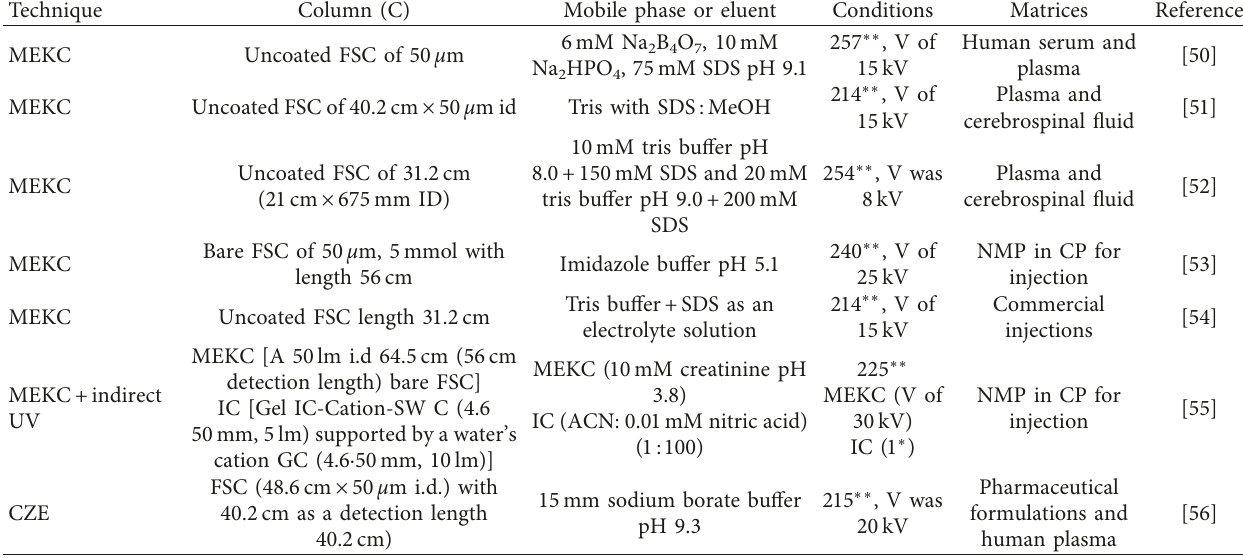
Table 2: Micellar electrokinetic chromatographic methods for determination of CP.